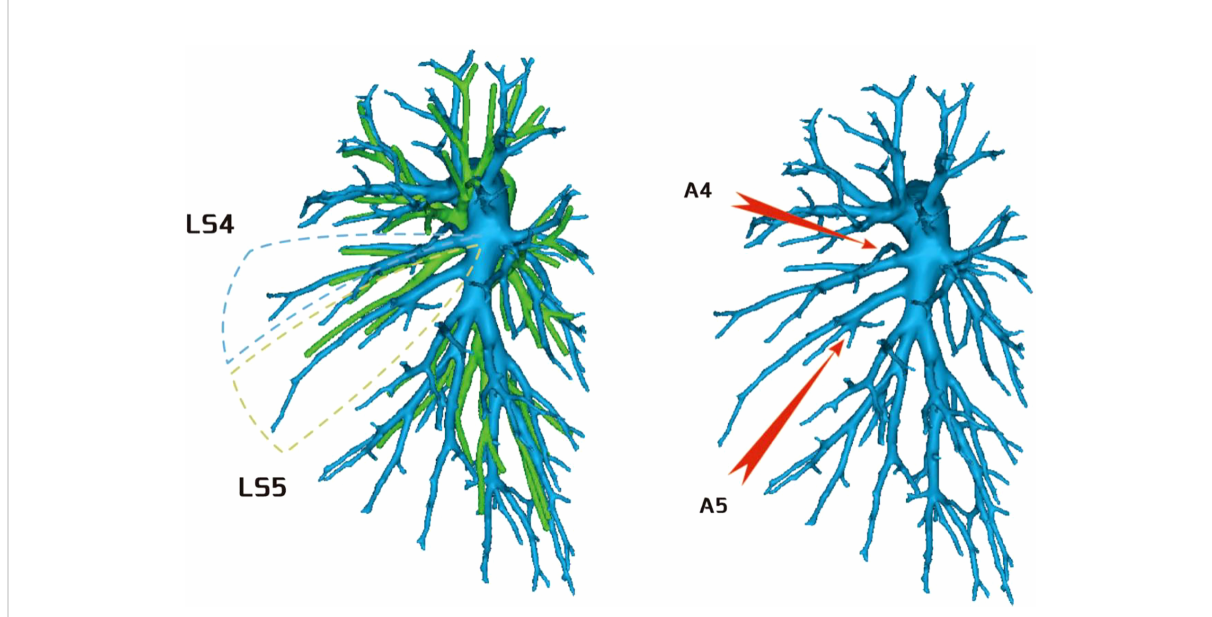
FIGURE 10 A4 + 5 originated from the oblique cleft side of the lingular